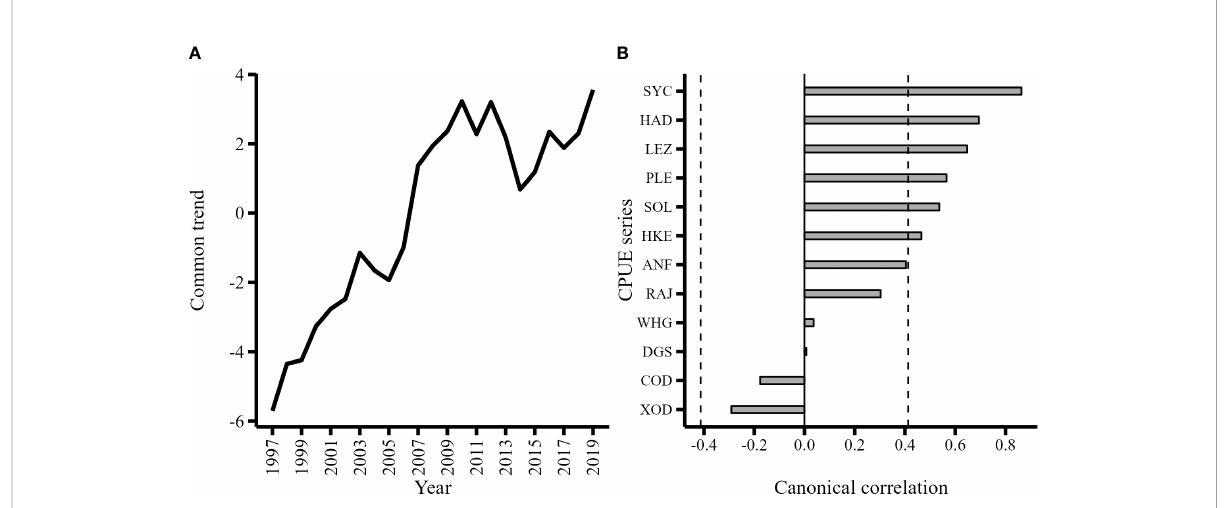
FIGURE 7 (A) Common trend estimated from optimal DFA model; (B) Canonical correlations between each CPUE series and the common trend. Canonical correlations greater or less than 0.413 (vertical dashed line) indicate CPUE series were signi fi cantly correlated ( a = 0.05) with the common